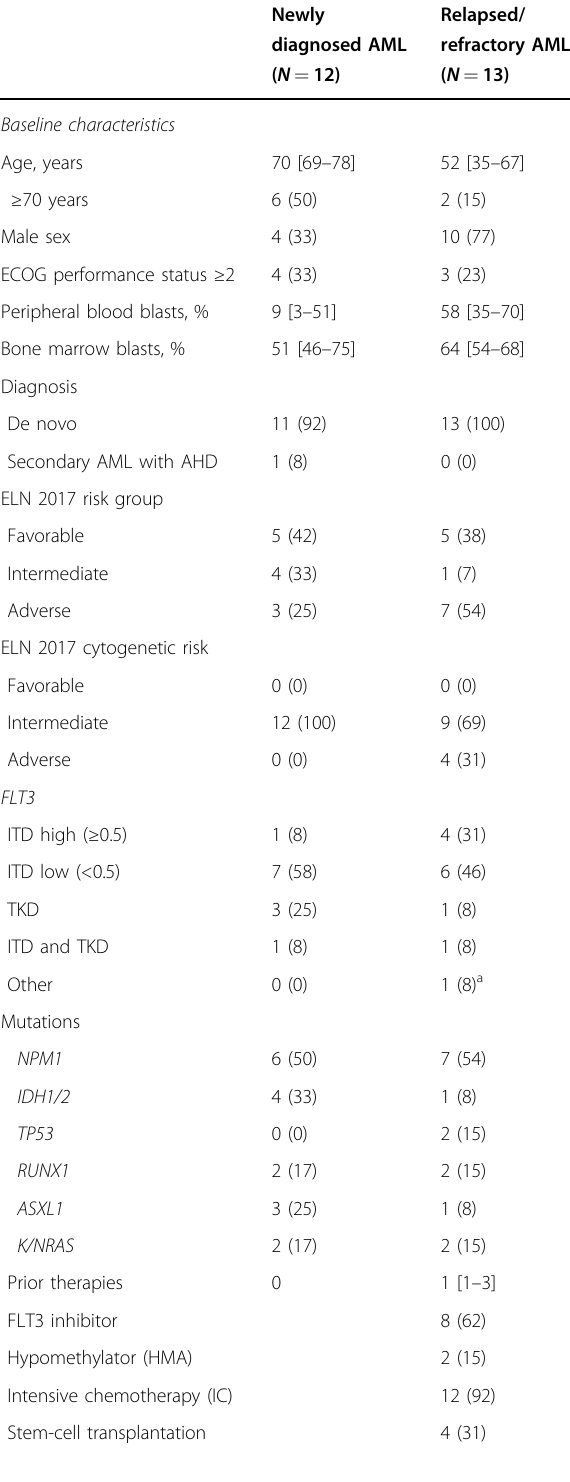
Table 1 Baseline characteristics and outcomes of patients with FLT3 mut AML treated with FLT3 inhibitor, venetoclax, and 10-day